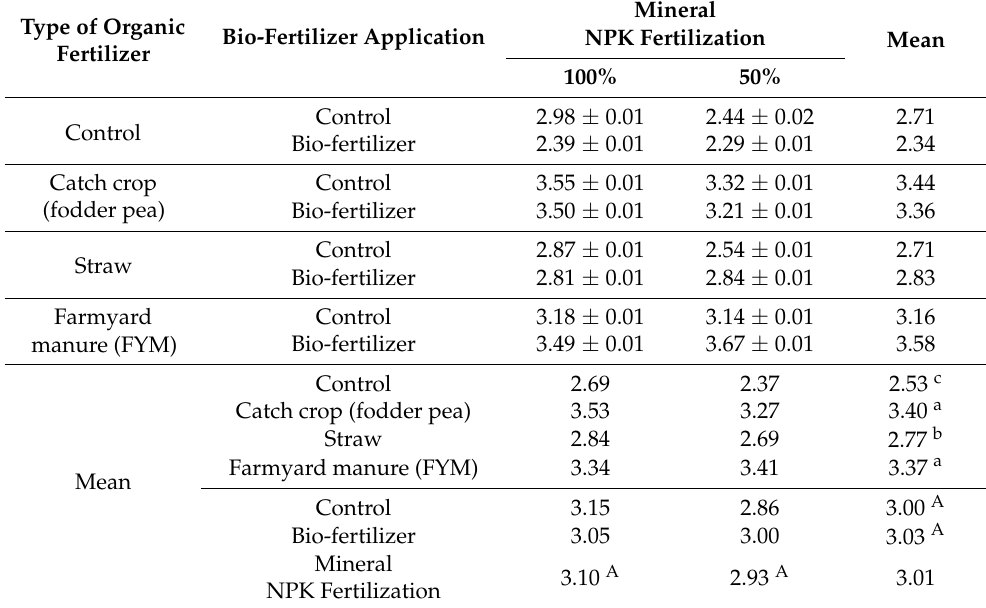
Table 8. Chlorogenic acid content in potato tubers depending on the applied research factors after 6 months of storage (g · kg − 1 DM) (mean from 3